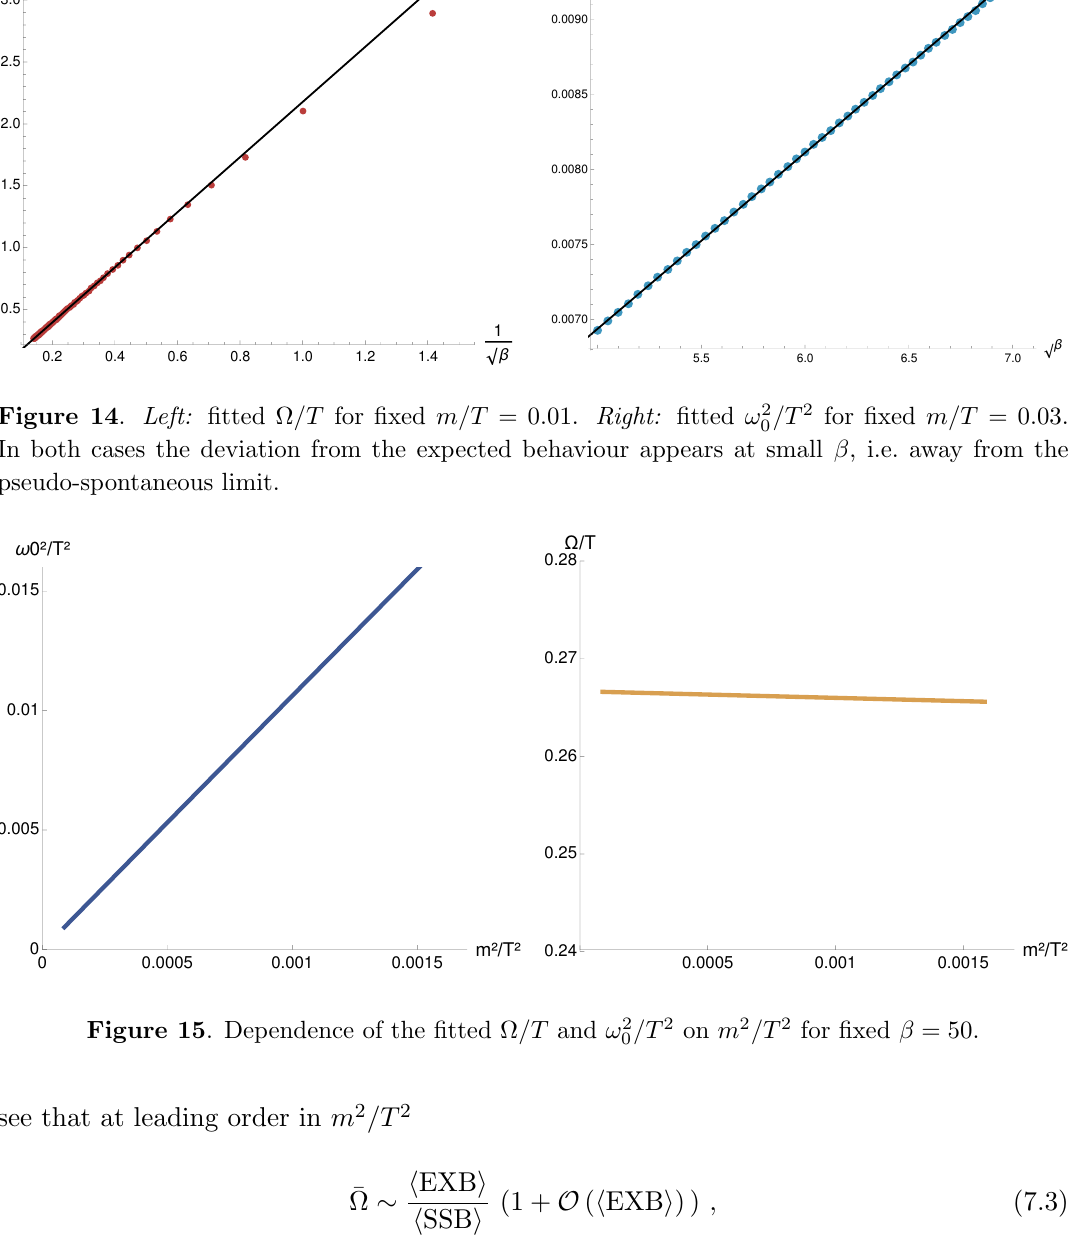
Figure 15 . Dependence of the (cid:12)tted (cid:10) =T and ! 2